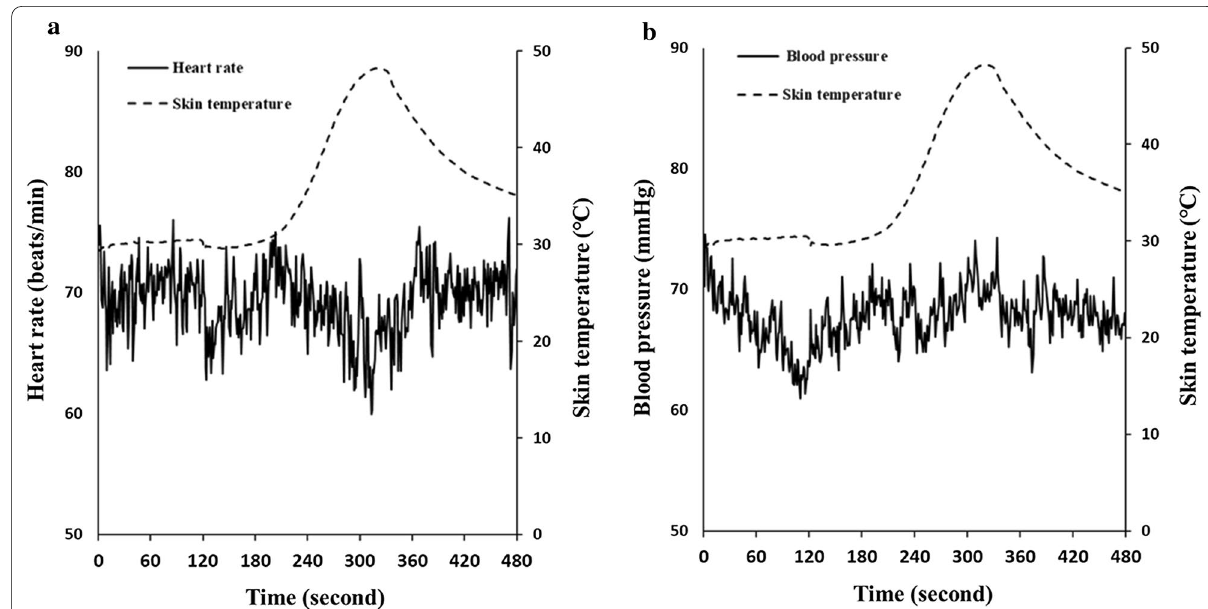
Fig. 1 Representative traces of heart rate ( a ) and blood pressure ( b ) responses to heat stimulation by indirect moxibustion in the same patient. The solid line represents heart rate or blood pressure, and the dotted line represents skin